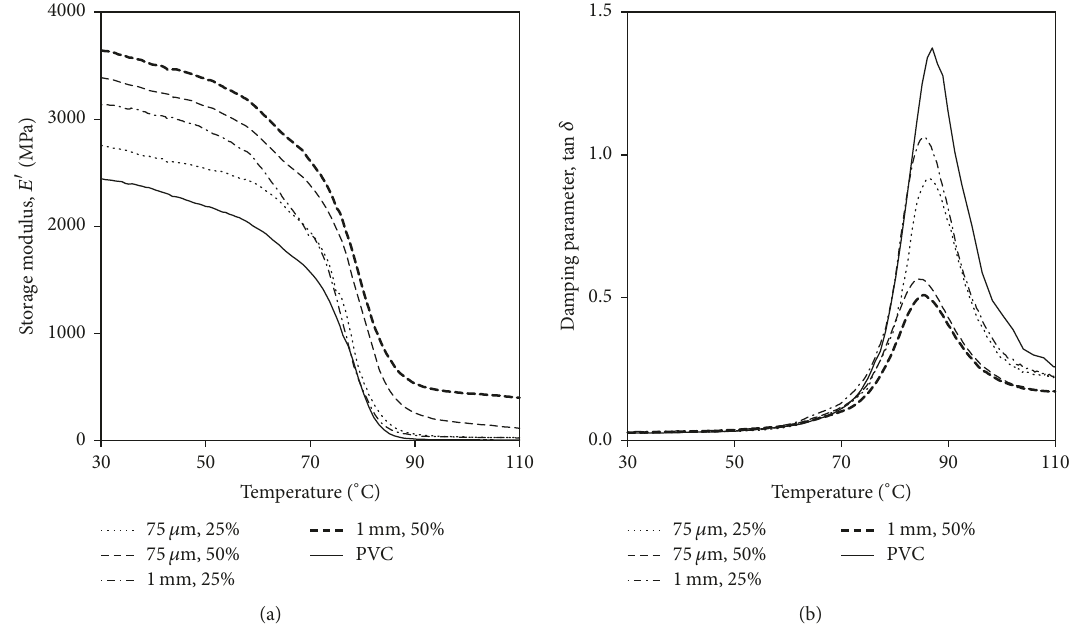
Figure 3: Typical DMTA plots of PVC/bamboo composites derived from C 1 , in comparison to pure PVC composites (also from C 1 ): (a) storage modulus, 𝐸 󸀠 , and (b) tan 𝛿 .